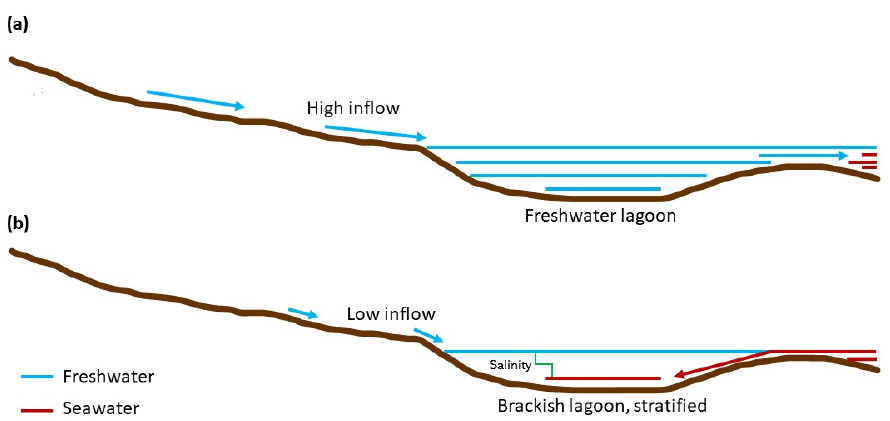
Figure 2. Water circulation models: ( a ) in high freshwater inflow; ( b ) in low inflow, with seawater entrance and high salinity lagoons.